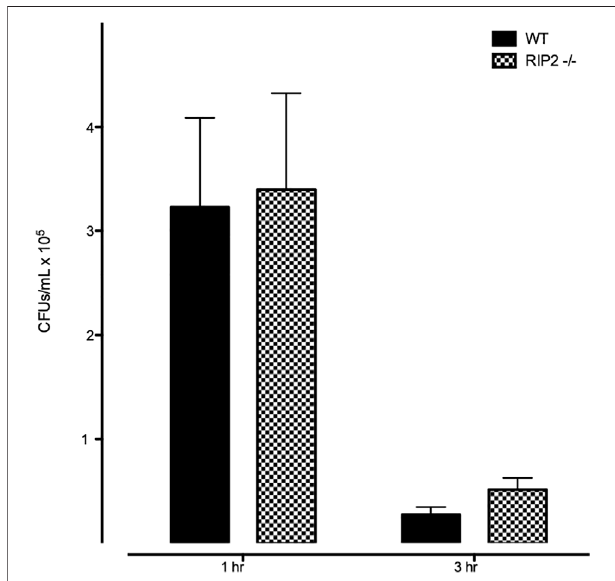
FIGURE 7 | Lack of effect of RIP2 deletion on macrophage NTHi phagocytosis and bacterial killing. In a standard in vitro assay for phagocytosis, peritoneal macrophages from WT and RIP2 − / − mice exhibited similar uptake of bacteria after 1 h incubation with NTHi, and a similar reduction after 2 additional hours without NTHi exposure.